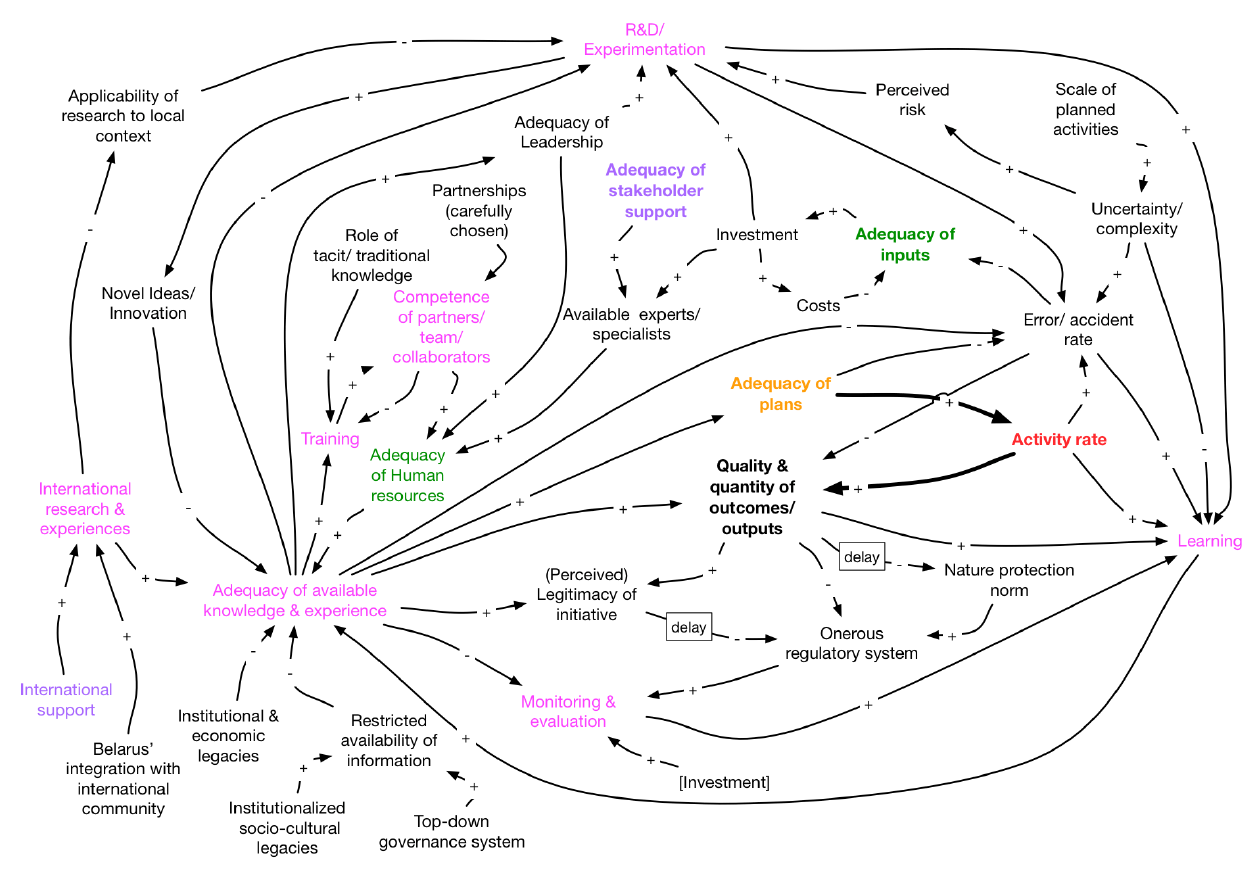
Fig. 8 . Submodel unpacking causal dynamics influencing the adequacy of learning and knowledge for wetland restoration initiatives. Learning and knowledge/experience concepts are disaggregated in this submodel in order to clarify causal pathways. These concepts are otherwise aggregated together in the other